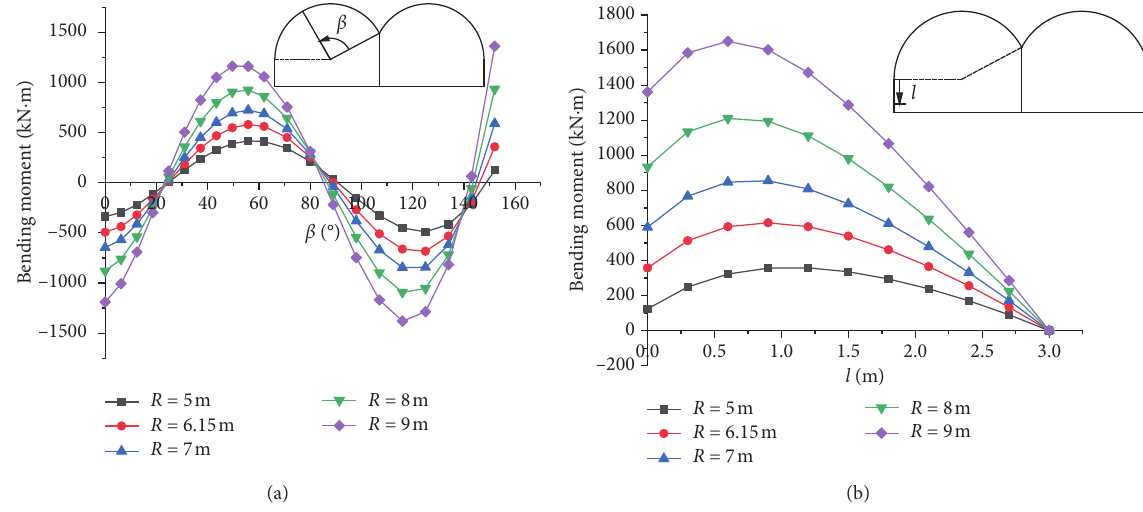
Figure 22: Variations of bending moment with R: (a) along the arch ring; (b) along the side